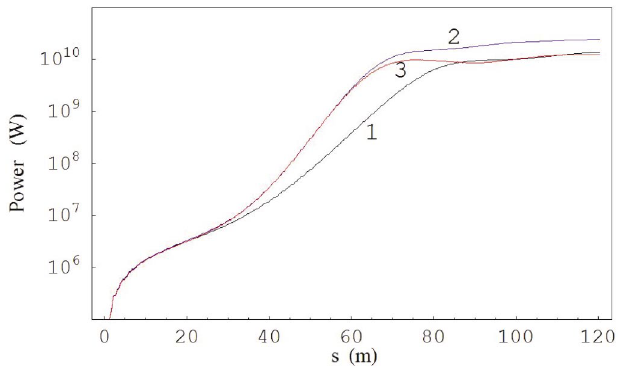
FIG. 8. (Color) The average x-ray power versus distance for an electron beam with 1.2 mm-mrad normalized emittance: 1 is the standard case without conditioning, 2 is the case of an ideal conditioning (see text for explanation), and 3 is the case of a practical conditioning with a proposed